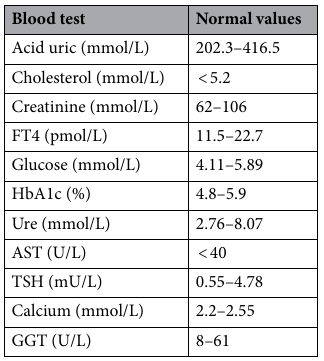
Table 1. Thresholds for detecting normal